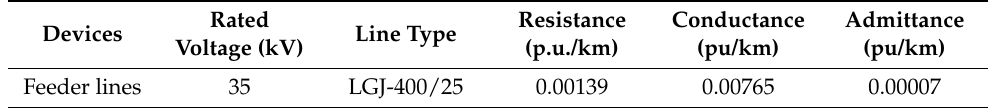
Table A3. Parameters of feeder lines in wind